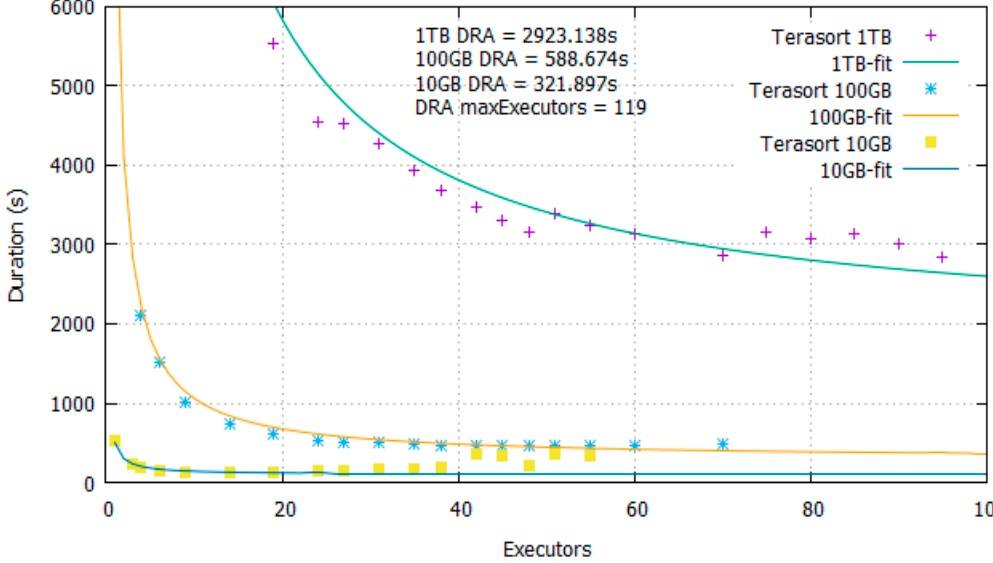
Figure 5. Fitted elbow curves of job duration vs. executors for Spark-Bench Terasort 10 GB, 100 GB, and 1 TB workloads, and their corresponding runtimes with Dynamic Resource Allocation (DRA) enabled. Step 4. Input the fit parameter a to the BToP algorithm (Algorithm 1) to obtain the recommended optimal number of executors for a workload (Figure